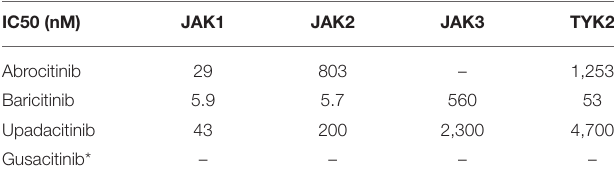
TABLE 4 | Summary of half maximal inhibitory concentration (IC50) of oral JAK inhibitors. IC50 (nM) JAK1